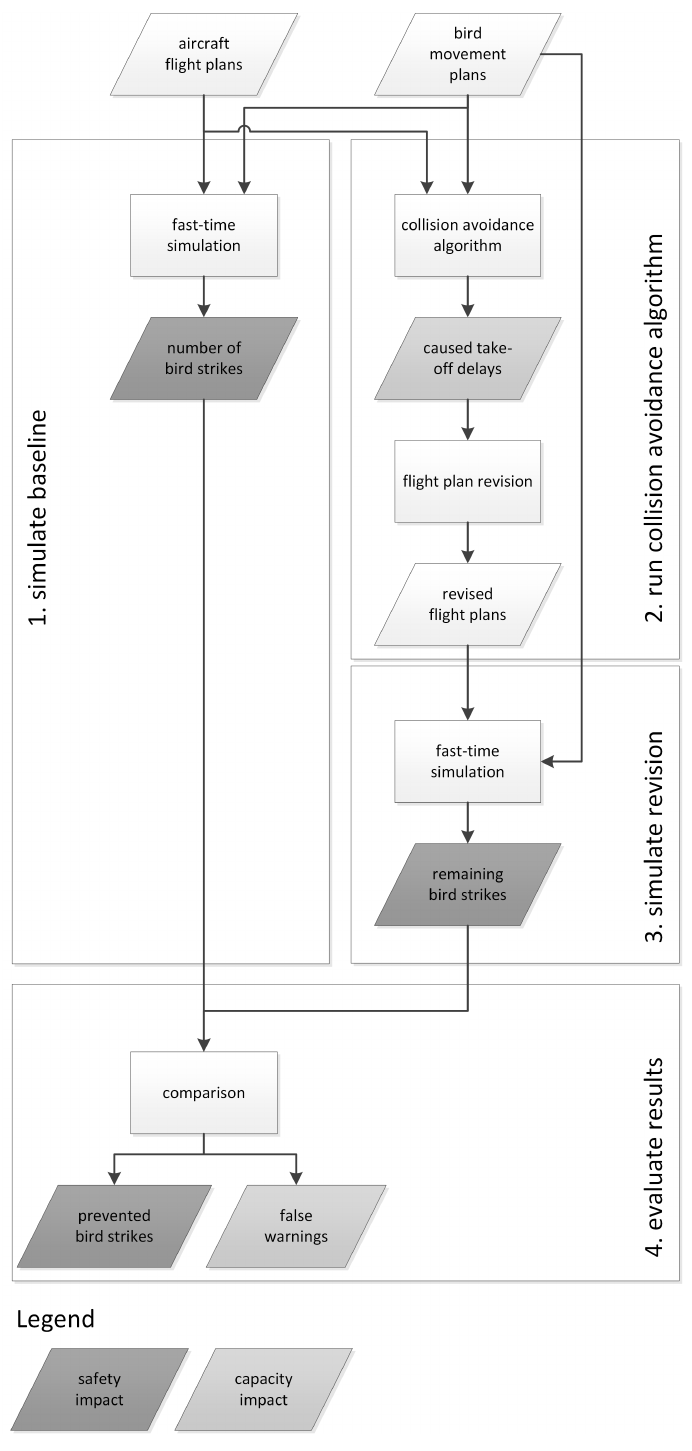
Figure 3. Validation